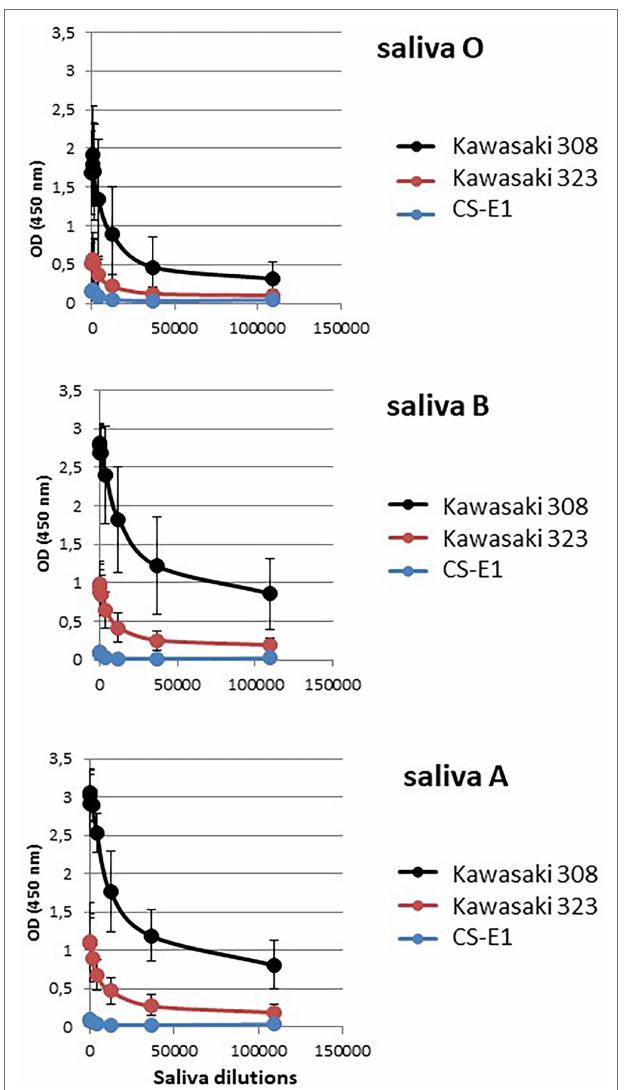
FIGURE 5 | Relative affinity assay. A subset of six representative saliva samples for each ABO blood group was serially diluted by 3-fold and used to assess VLP affinity for each variant. Dilutions are indicated below the graph (abscissa). Each variant is color-coded, and the legend is indicated on the right side of each graph. Values are means of six individual experiments where standard deviations are shown by vertical bars. Blood groups are indicated on the left side of the